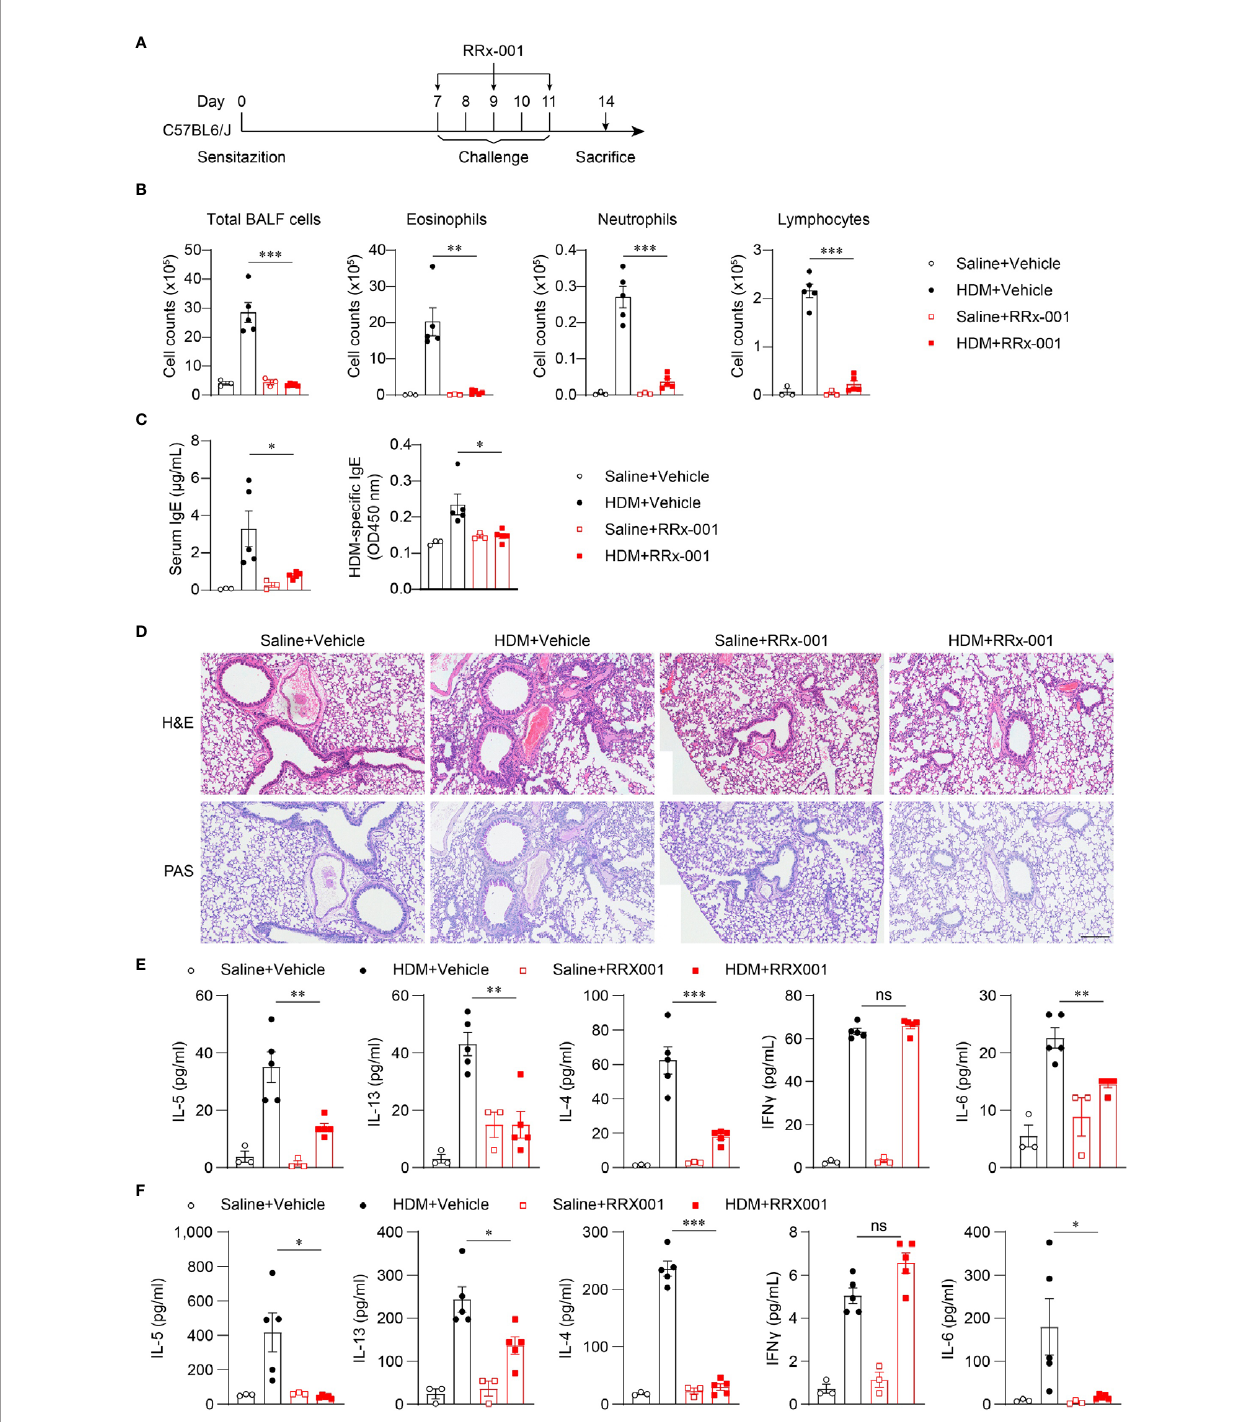
FIGURE 5 | RRx-001 treatment has therapeutic effects on HDM-induced allergic asthma. (A) Mice were induced allergic asthma with 10 m g HDM i.n. on day 0 and days 7-11, and given 10mg/kg RRx-001 or vehicle i.p. on days 7, 9, and 11. The mice in control group were challenged by inhaling saline, and given 10mg/kg RRx-001 or vehicle i.p. on days 7, 9, and 11. On day 14, all mice were euthanized for analysis. (B – F) WT mice were induced allergic asthma with HDM and treated with RRx-001 or vehicle. (B) Counts of total BALF cells, eosinophils, neutrophils and lymphocytes. (C) ELISA analysis of IgE and HDM-speci fi c IgE in serum. (D) Histological analysis of lung sections stained with H&E and PAS (Scale bar = 200 m m); n = 3 biologically independent experiments. ELISA analysis of IL-4, IL-5, IL-13, IL-6 and IFN g in BALF (E) and supernatants of MLN cells obtained from control or challenged mice after or without restimulation with HDM (F) . n = 3-5 biologically independent mice (B, C, E, F) . Statistical signi fi cances were analyzed by unpaired Student ’ s t -test: * P < 0.05, ** P < 0.01, *** P < 0.001, ns (not signi fi